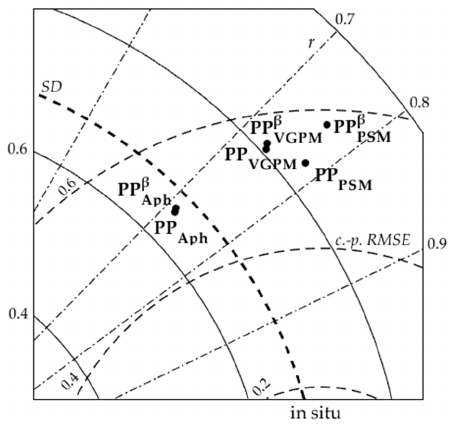
Figure 5. Taylor diagram of log satellite and in situ PP eu [mg C m − 2 day − 1 ] for the NEA using eight day OC-CCI composites ( N = 95). SD—solid arc, centre-pattern RMSE—dotted arc, r —dashed lines with a dot.